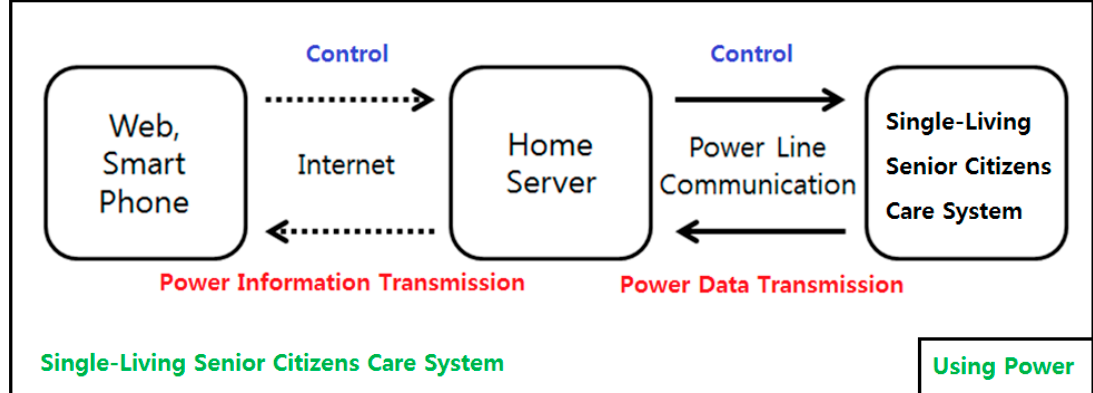
Figure 4. A Functional Diagram of the System (Scenario 1).